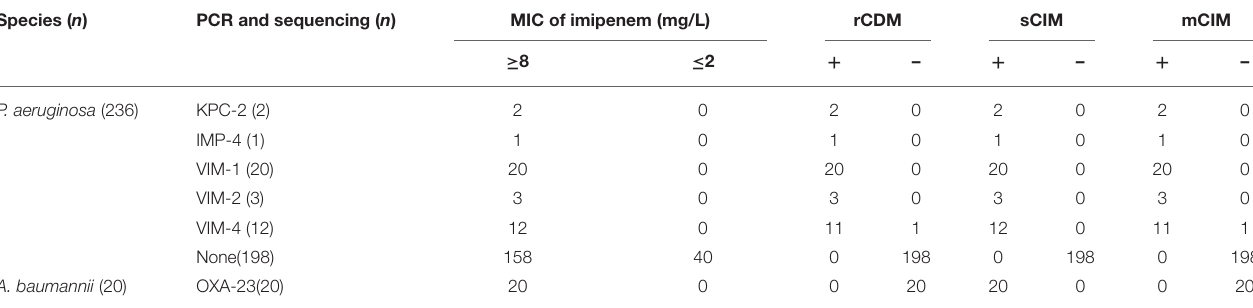
+ , positive; –, negative; rCDM, rapid carbapenemase detection method; sCIM, simplified carbapenem inactivation method; mCIM, modified carbapenem inactivation method; MIC, minimum inhibitory concentration. TABLE 2 | Detection of carbapenemase-producing P. aeruginosa and A. baumannii by rCDM, mCIM, and sCIM. Species ( n ) PCR and sequencing ( n ) MIC of imipenem (mg/L)